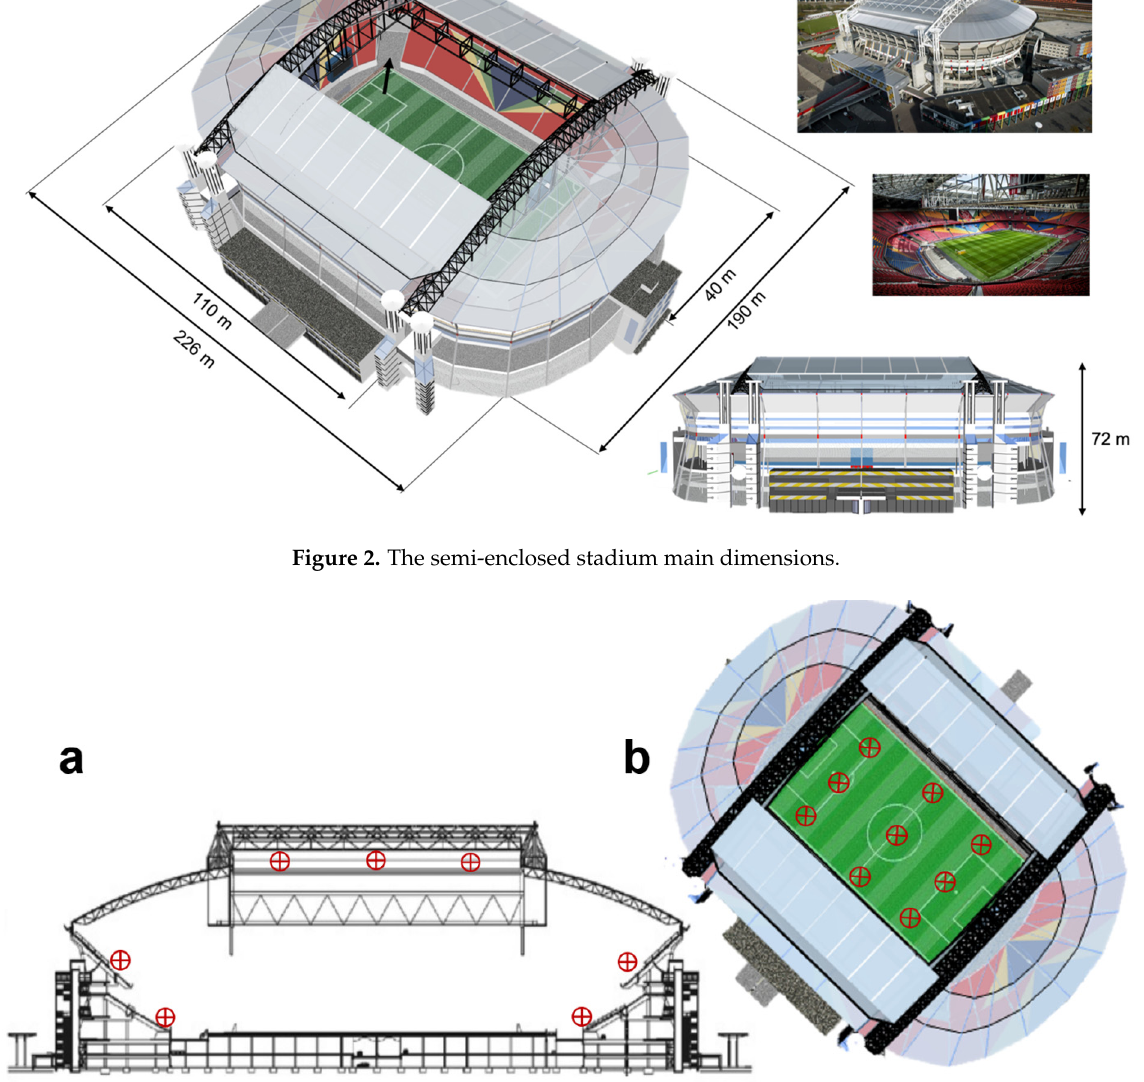
Figure 3. Grid independence analysis: ( a ) Measurement points on the cross-section of the stadium. ( b ) Measurement points on the pitch.